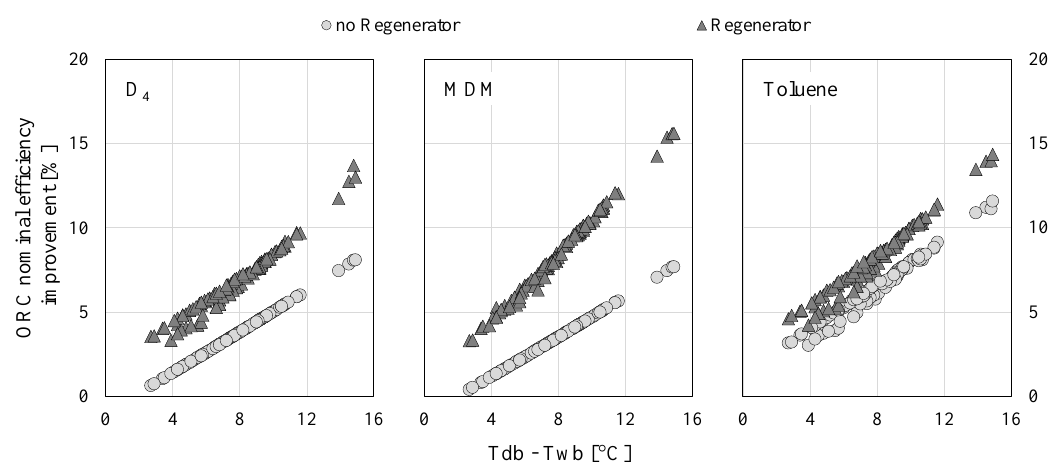
Figure 10. Impact of condenser type on ORC nominal